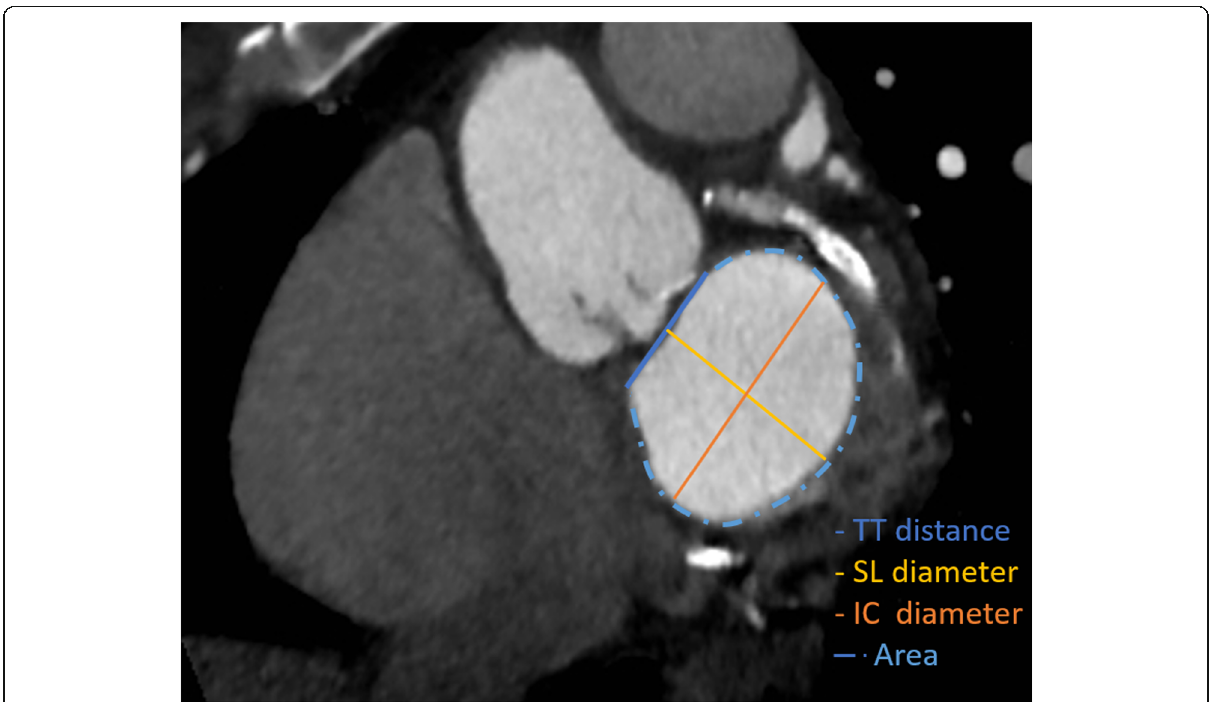
Fig. 2 D-shaped segmentation of mitral annulus on cardiac computed tomography angiography (CCTA). Traced in blue is the trigone-to-trigone diameter, in yellow the septal-to-lateral diameter, in orange the intercommissural diameter, and the dashed light blue line plus the trigone-to- trigone diameter depict the mitral